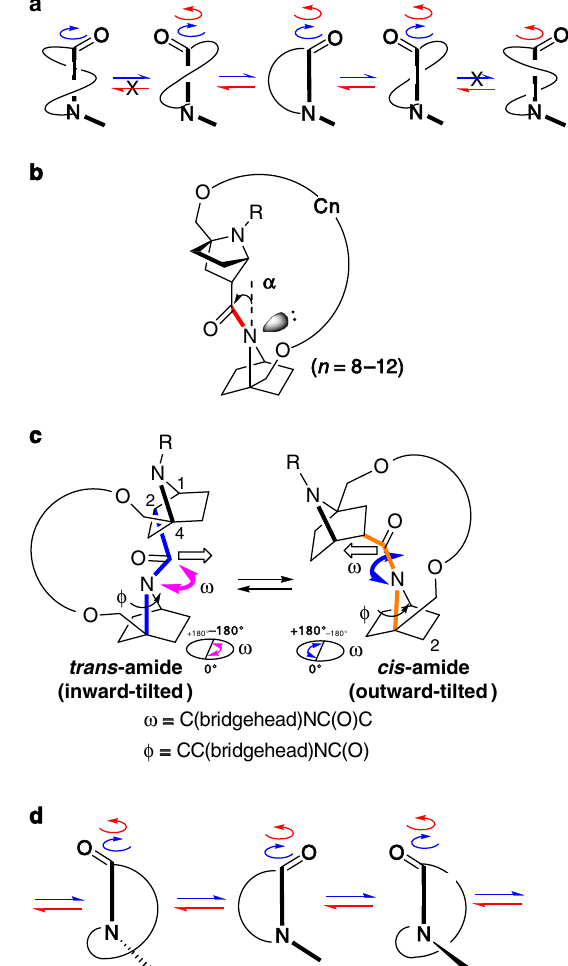
Fig. 1 Lactam amide rotations. a Hindered rotation of coiled lactam amides. b Nitrogen pyramidalization of tertiary amide lactams of 7-azabicyclo[2.2.1] heptane. c Equilibrium of trans and cis amides in the bicyclic N-pyramidal lactam. d Spinning of N-pyramidal lactam through 360